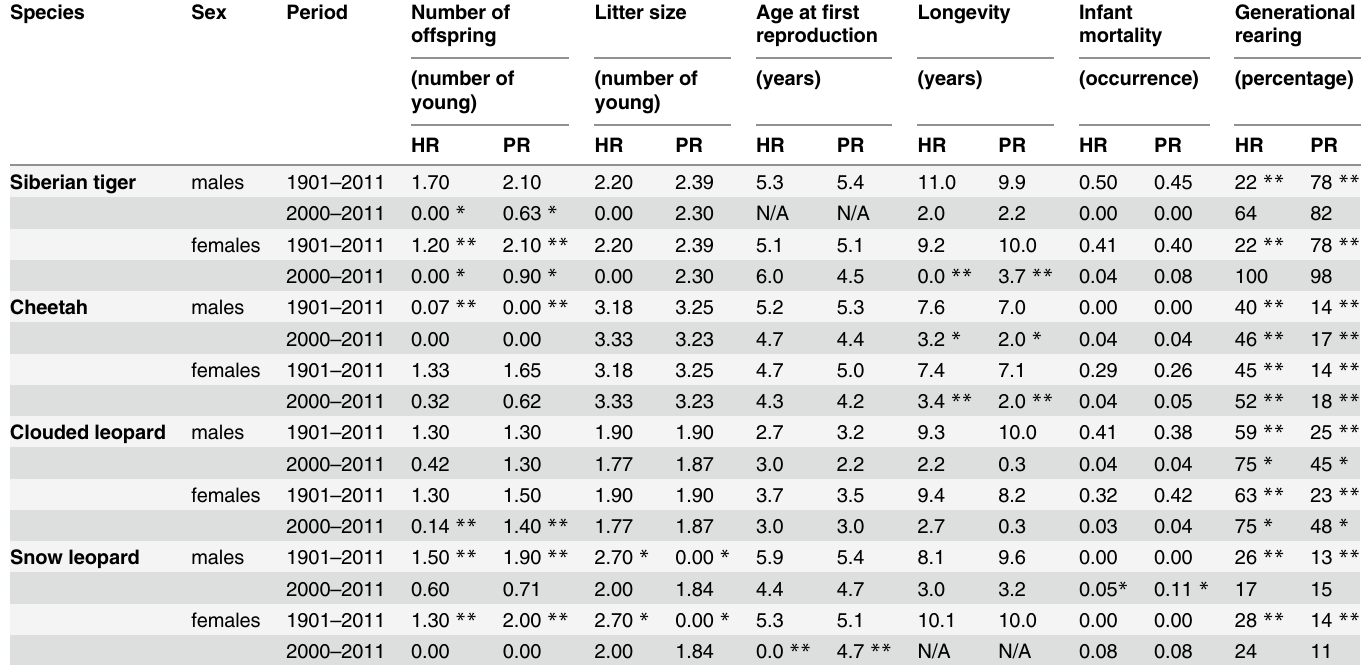
Table 1. Summary of results from each analysis. Species Sex Period